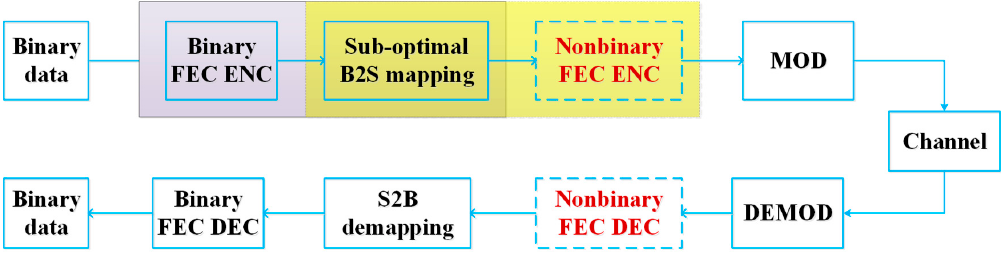
figure of merit [53], or minimizing mean-square error of Gaussian distribution [54], etc. Typically, the lower-amplitude constellation points will be more concentrated around the origin. Generalized